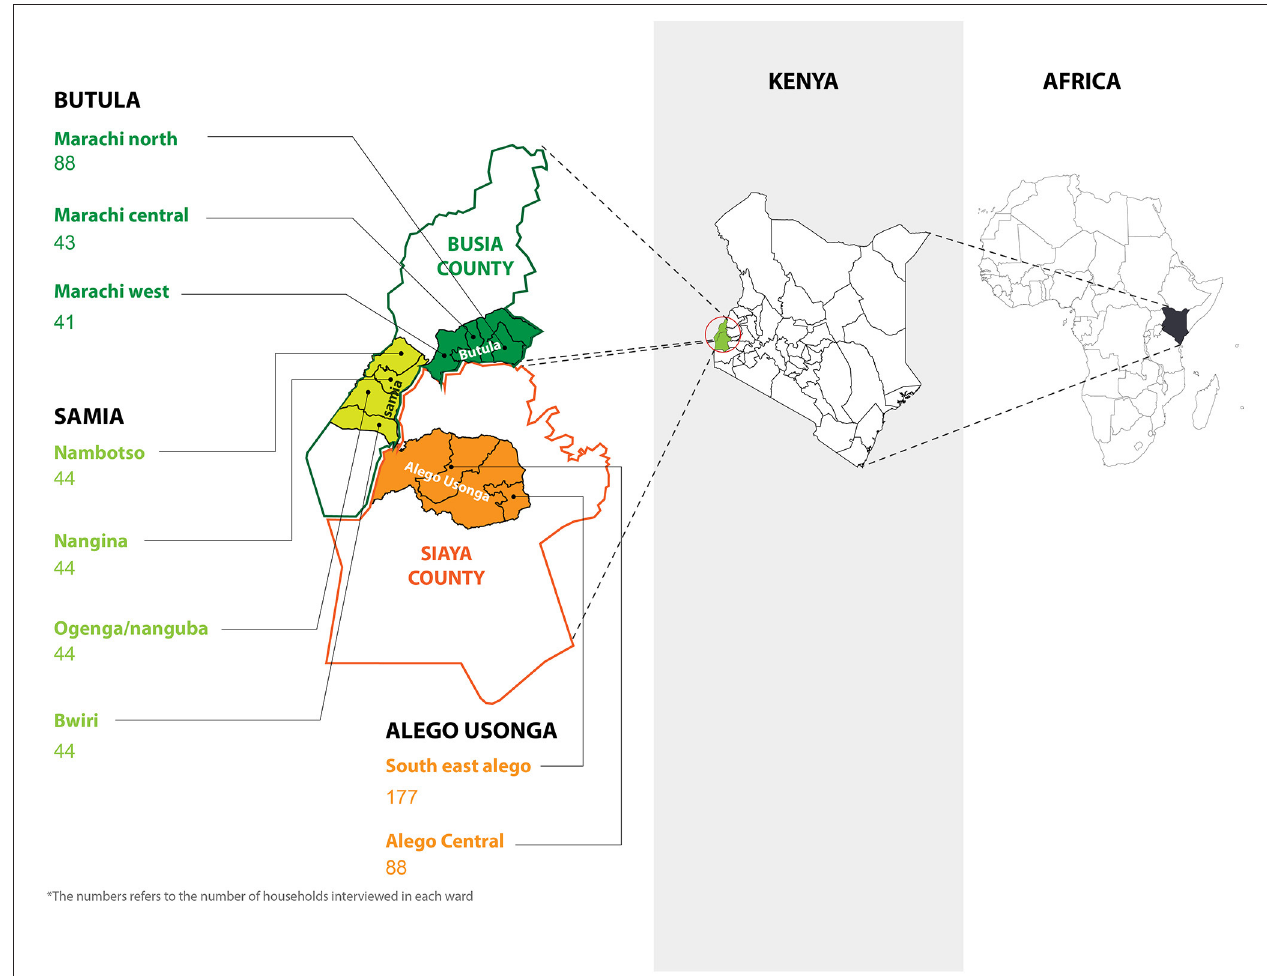
FIGURE 1 | Map of study areas in western Kenya and sample sizes per